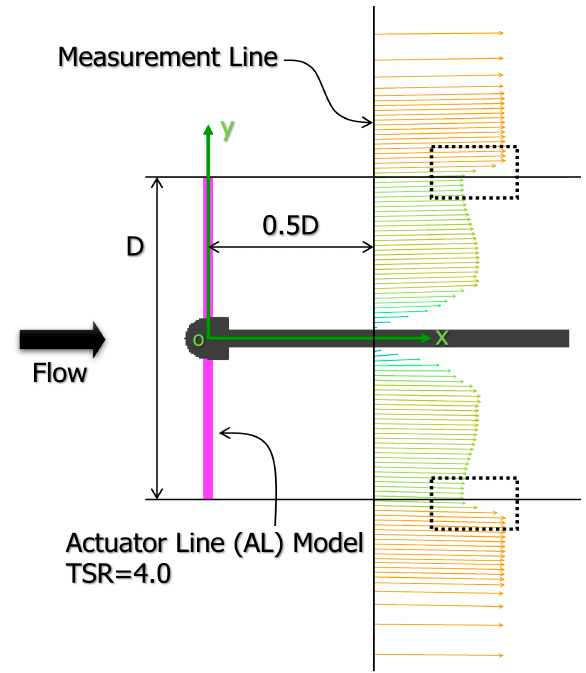
Figure 10. Velocity vectors for time-averaged flow fields at x = 0.5 D: x–y plane (top view). It is difficult to distinguish the figures, so the number of vectors is thinned out.